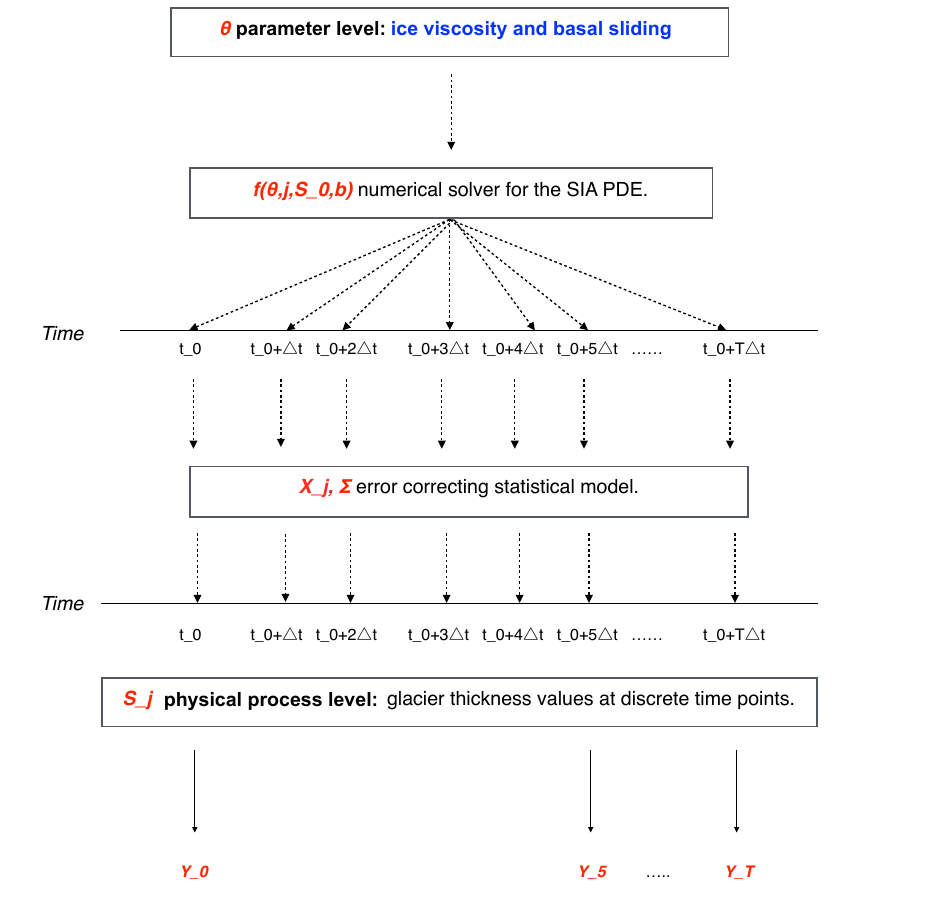
Figure 3. Schematic of the physical–statistical BHM that has been constructed based on the SIA PDE. The main parameters and variables for each module of the physical–statistical model are highlighted in red. The main levels of a physical–statistical model shown in Fig. 2 are displayed here, along with the parameters and variables describing each